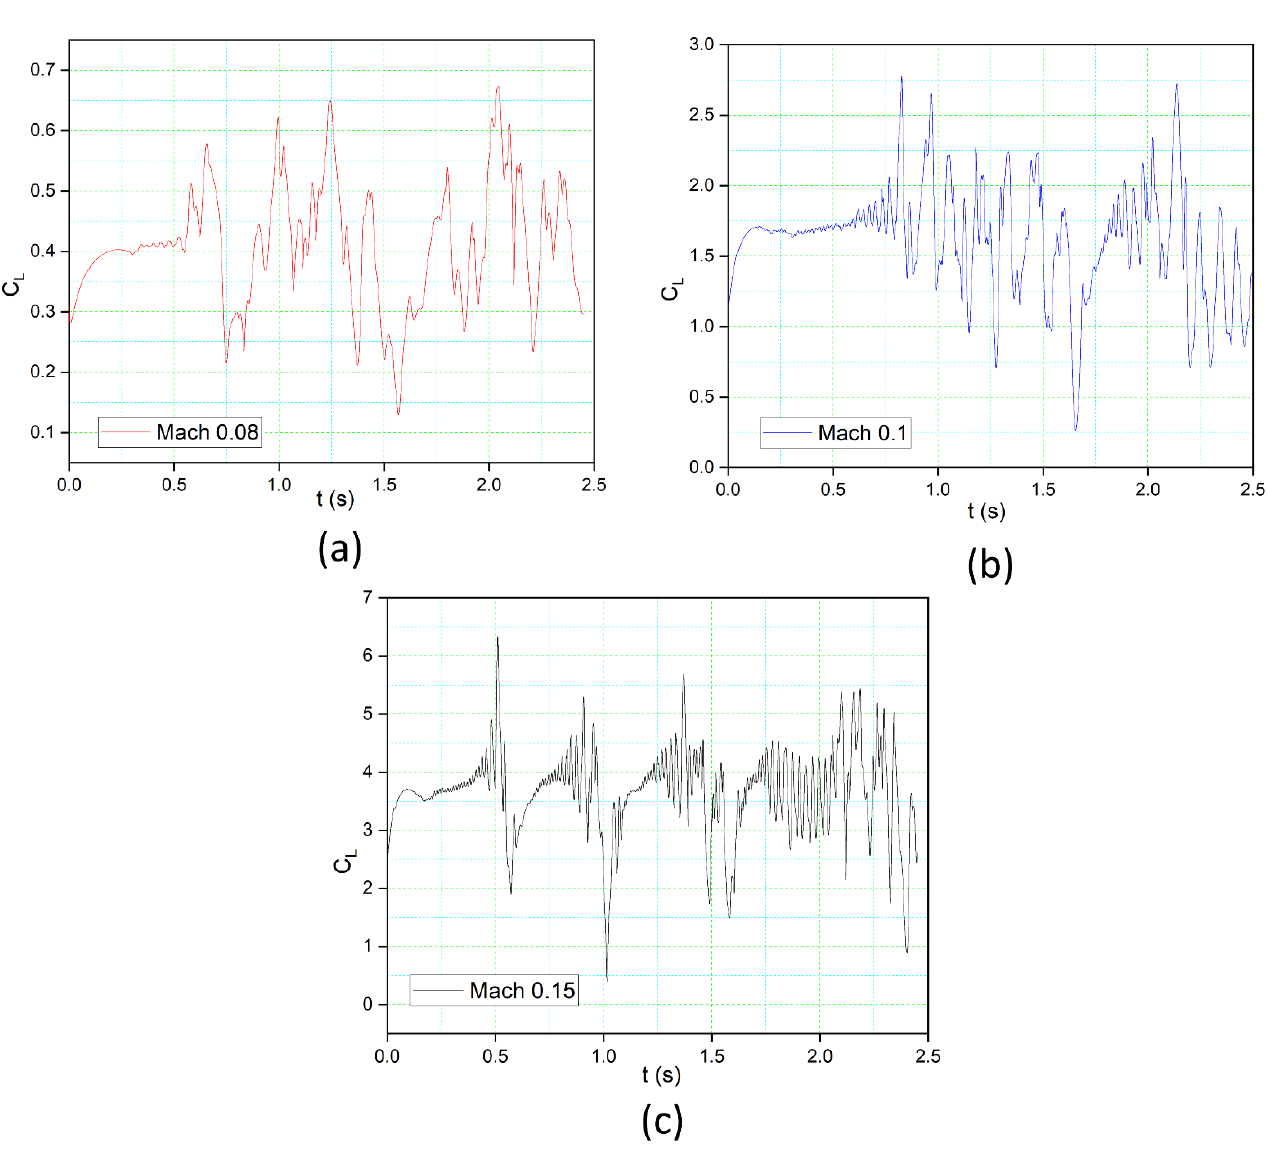
Figure 17. Aerodynamic lift coefficients for the morphing airfoil with time (s) at three different Mach numbers of ( a ) 0.08, ( b ) 0.1, and ( c ) 0.15.